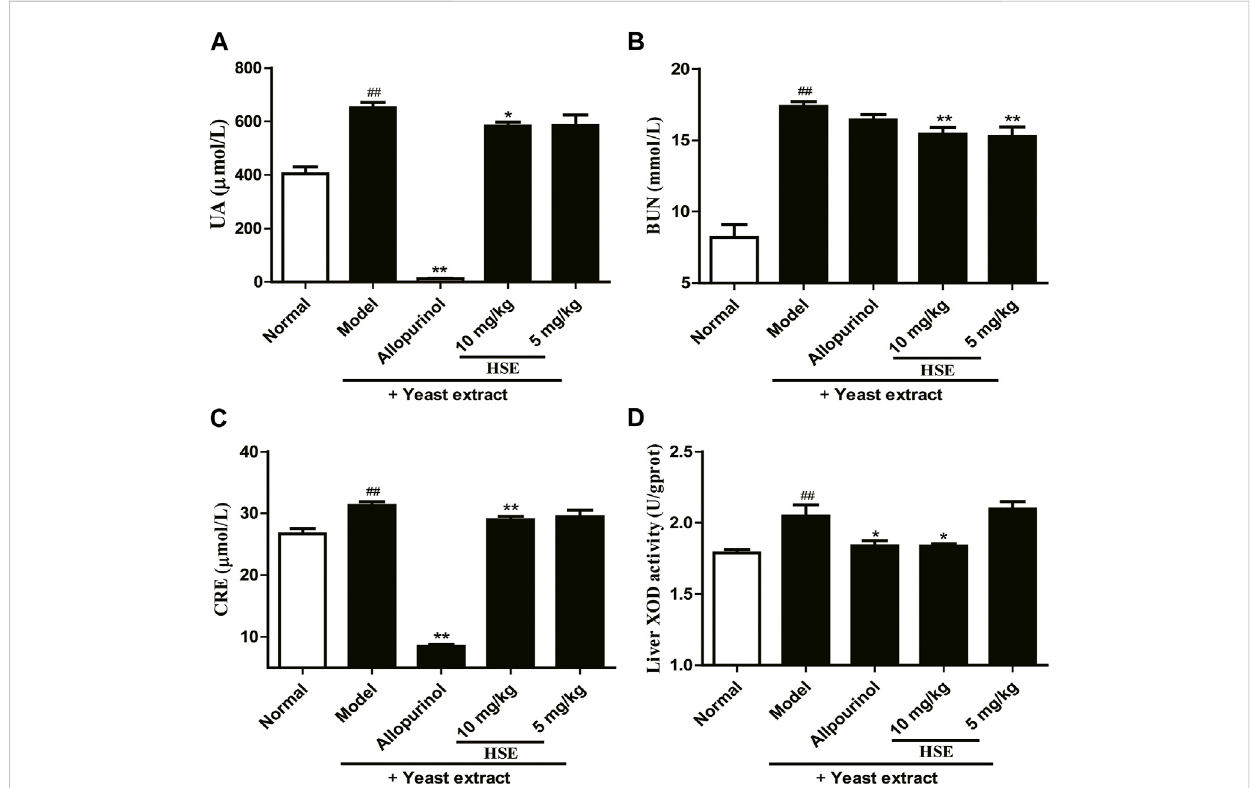
FIGURE 3 Effects of hesperetin (HSE) on serum parameters and hepatic xanthine oxidase (XOD) activity in mice with hyperuricemia induced by yeast extract. (A) Uric acid (UA) (B) Blood urea nitrogen (BUN) (C) Serum creatinine (CRE) (D) Hepatic xanthine oxidase (XOD) activity. The dose of allopurinol was 10 mg/kg in vivo experiments. Data are the mean ± SEM (n = 10). ## p < 0.01 versus the normal group; * p < 0.05 and ** p < 0.01 versus the model group. HSE, hesperetin; UA, uric acid; BUN, blood urea nitrogen; CRE, serum creatinine; XOD, xanthine